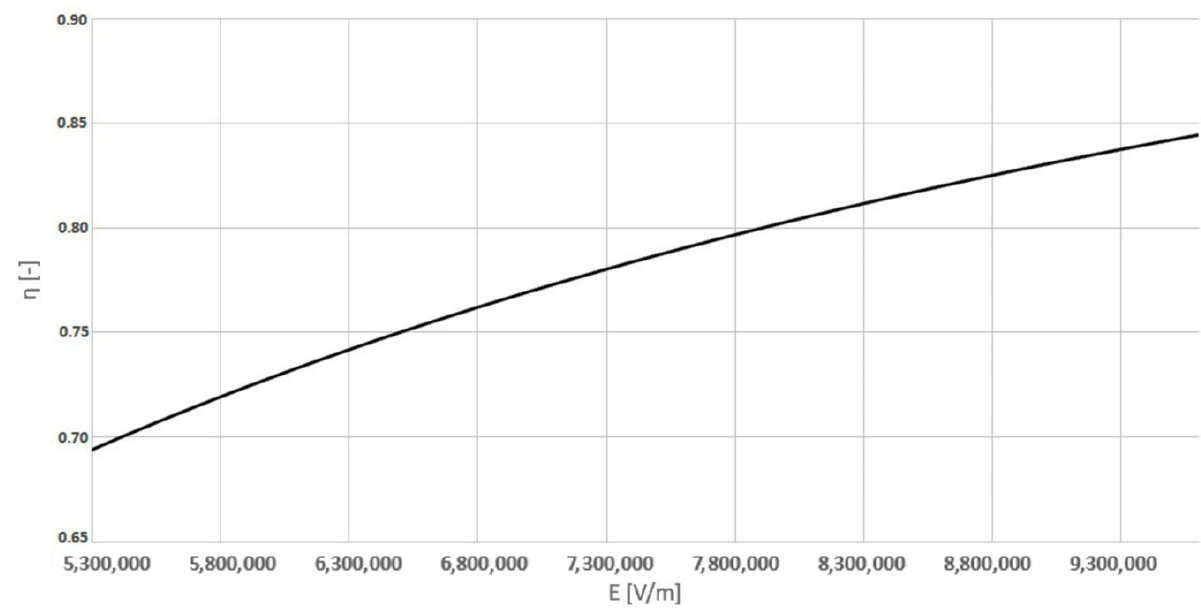
Figure 11. Theoretical efficiency of capture for the precipitator.